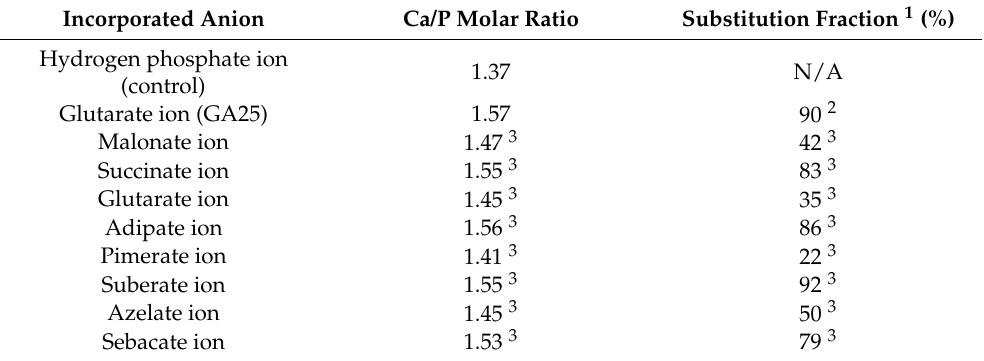
Table 1. Ca/P molar ratios and substitution fractions of the hydrated-layer hydrogen phosphate ions by dicarboxylate ions in the plain OCP (control) and the OCP sample synthesised using 25 mmol of glutaric acid (GA25), along with the previously reported data [33]. Incorporated Anion Ca/P Molar Ratio Substitution Fraction 1 (%) Hydrogen phosphate ion 1.37 N/A (control) Glutarate ion (GA25) 1.57 90 2 Malonate ion 1.47 3 42 3 Succinate ion 1.55 3 83 3 Glutarate ion 1.45 3 Adipate ion 1.56 3 86 3 Pimerate ion 1.41 3 Suberate ion Azelate ion Sebacate